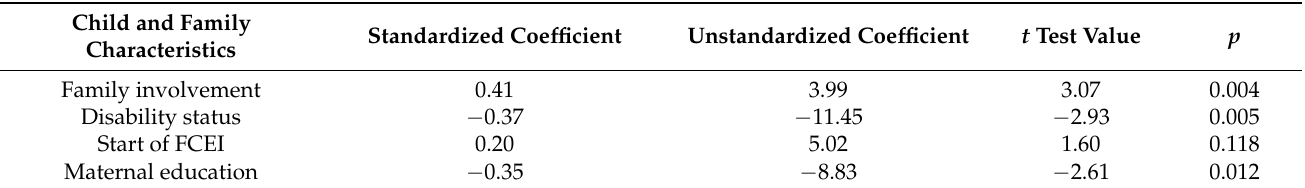
Table 6. Multiple regression predicting children’s expressive language outcomes at the age of 30